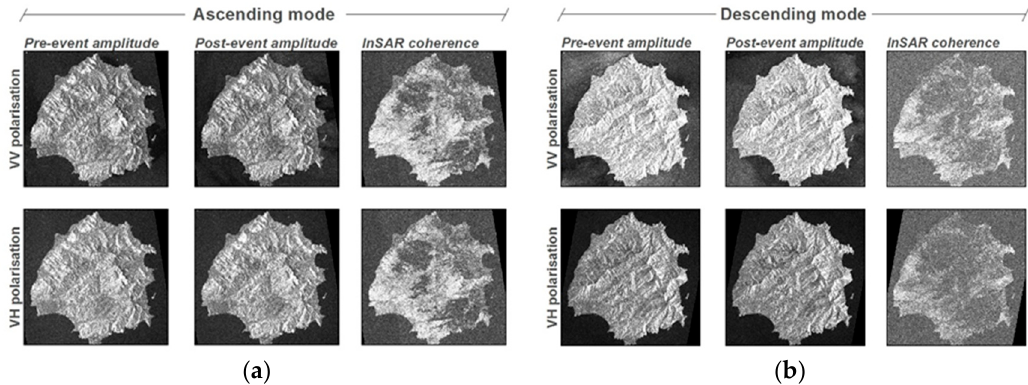
Figure 5. Results of the pre- and post-event amplitude and the coherence calculation in ( a ) ascending and ( b ) descending modes for both available polarizations, vertical–vertical (VV) and vertical–horizontal (VH).